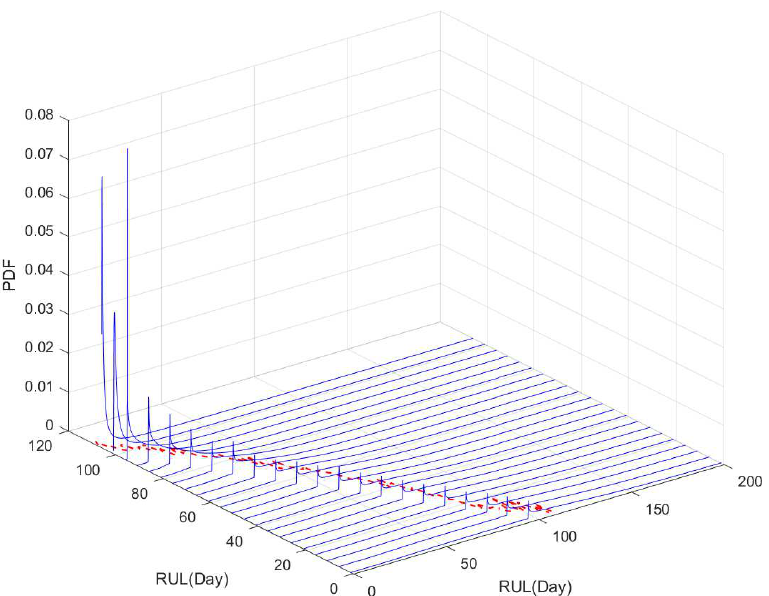
Figure 7. The PDFs of the estimated RUL based on our